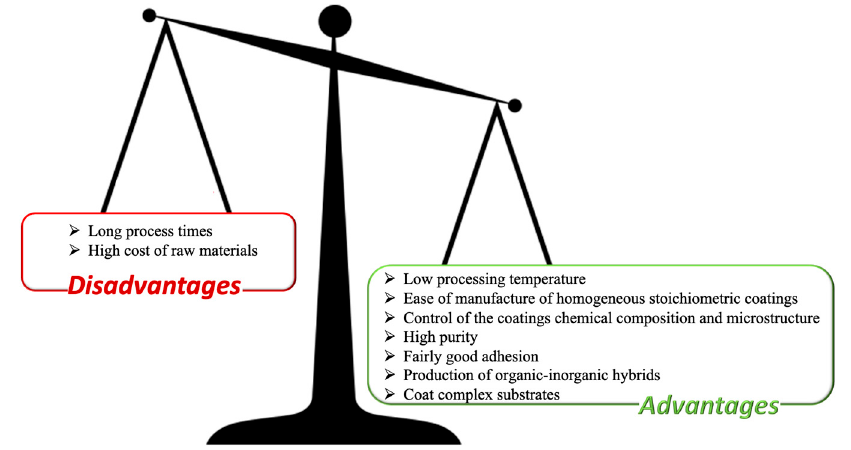
Figure 1. Advantages and disadvantages of sol-gel coating technology.